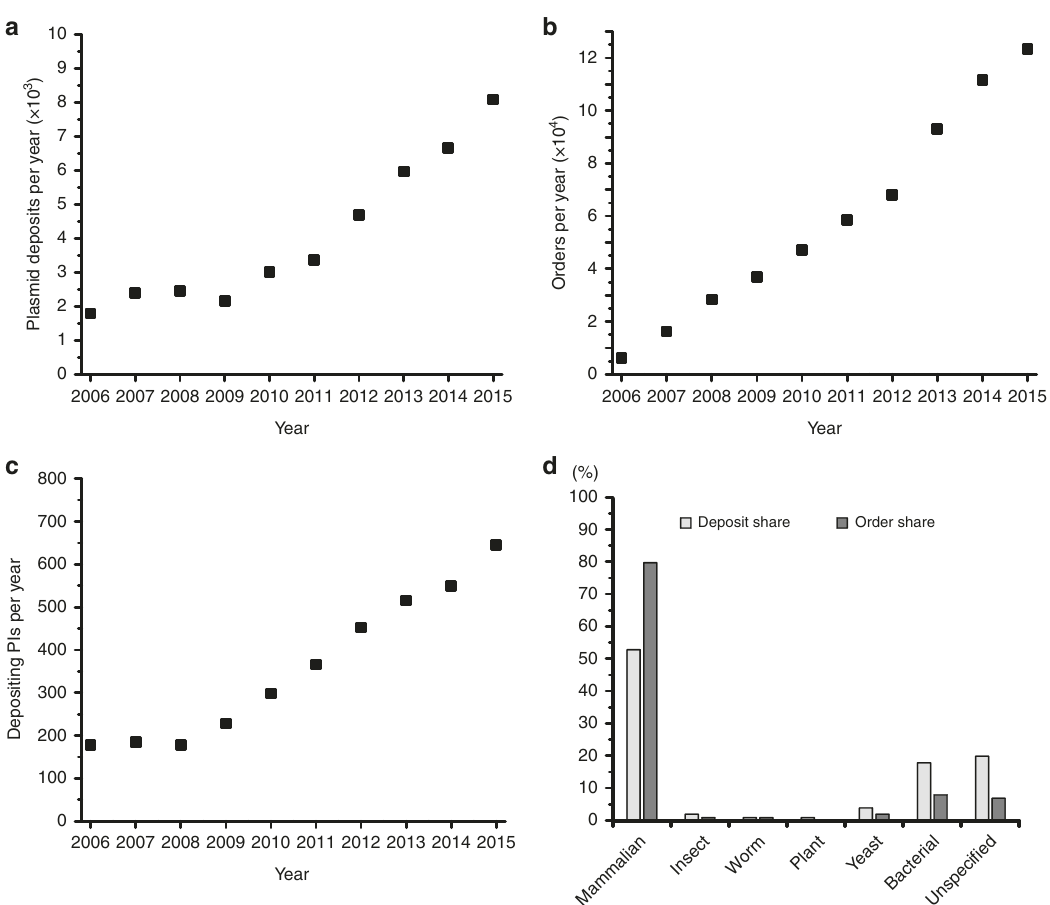
Fig. 1 Descriptive statistics of the Addgene plasmid repository, a representative source of sequences used in academic biological research. a Number of plasmids deposited per year during 2006 – 2015 in Addgene. b Number of orders per year from Addgene. c Number of unique depositing principal investigators (PIs) per year. d Share of deposits and orders for plasmids across different expression